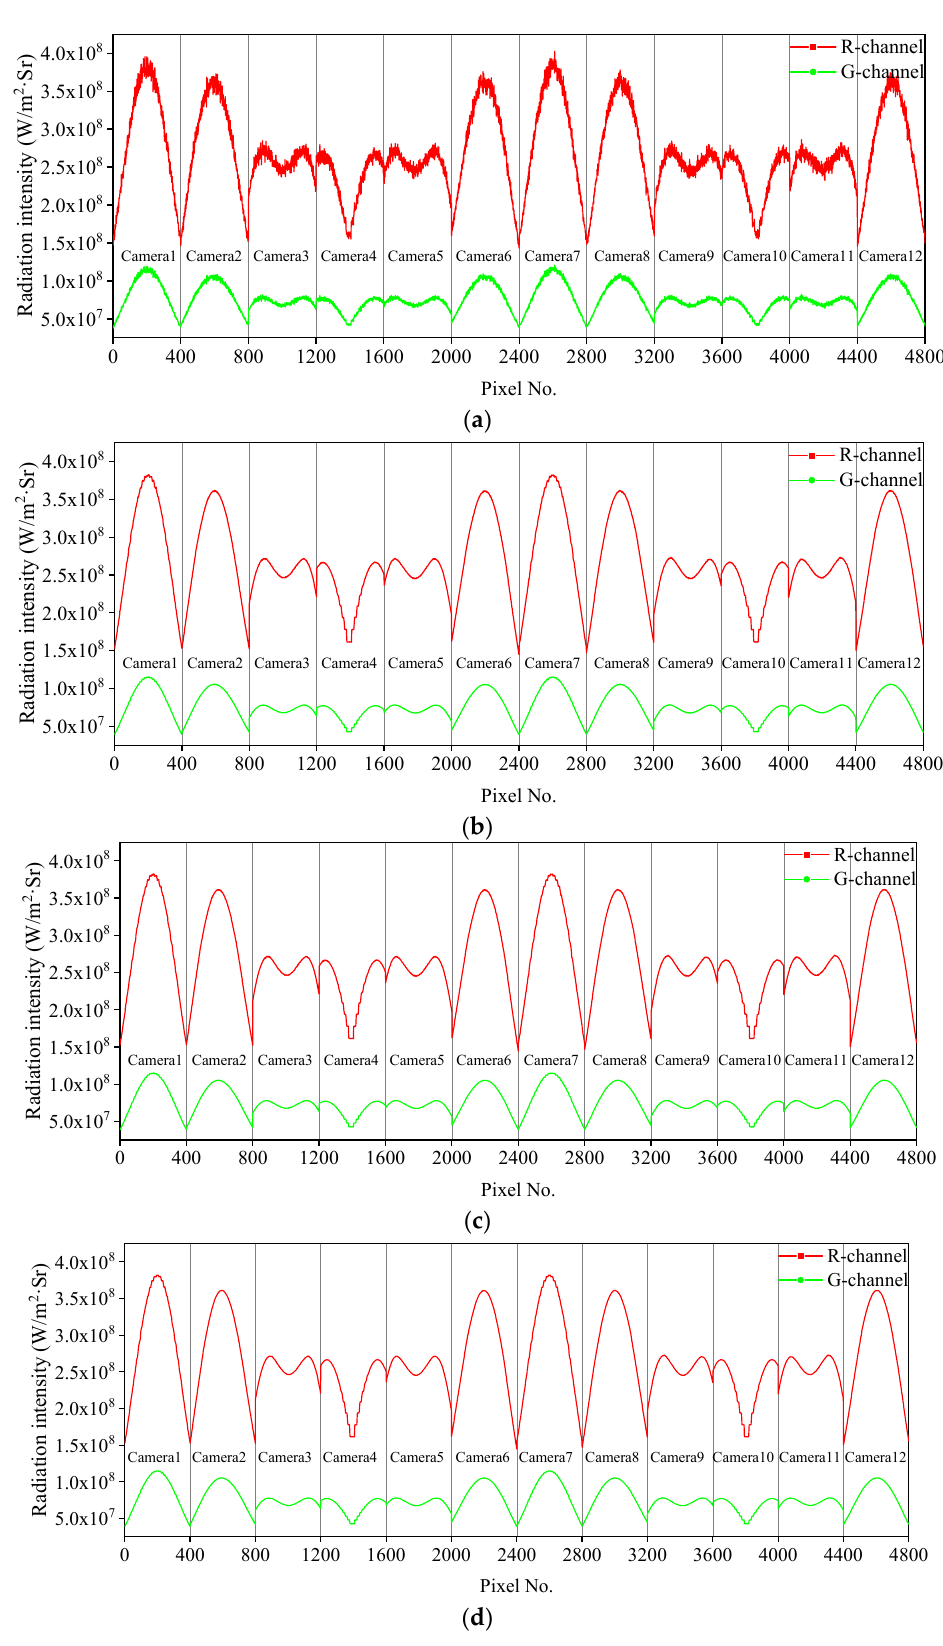
Figure 9. Theoretical radiation-intensity distribution after adding different noises: 39 dB ( a ), 63 dB ( b ), 65 dB ( c ) and 72 dB ( d ).